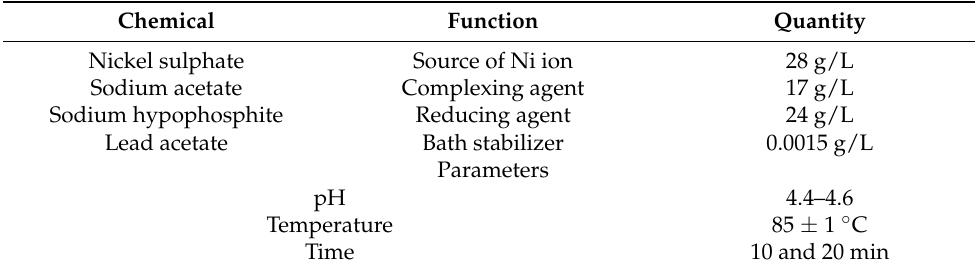
Table 2. Chemical composition and parameters of electroless nickel plating [7,35].